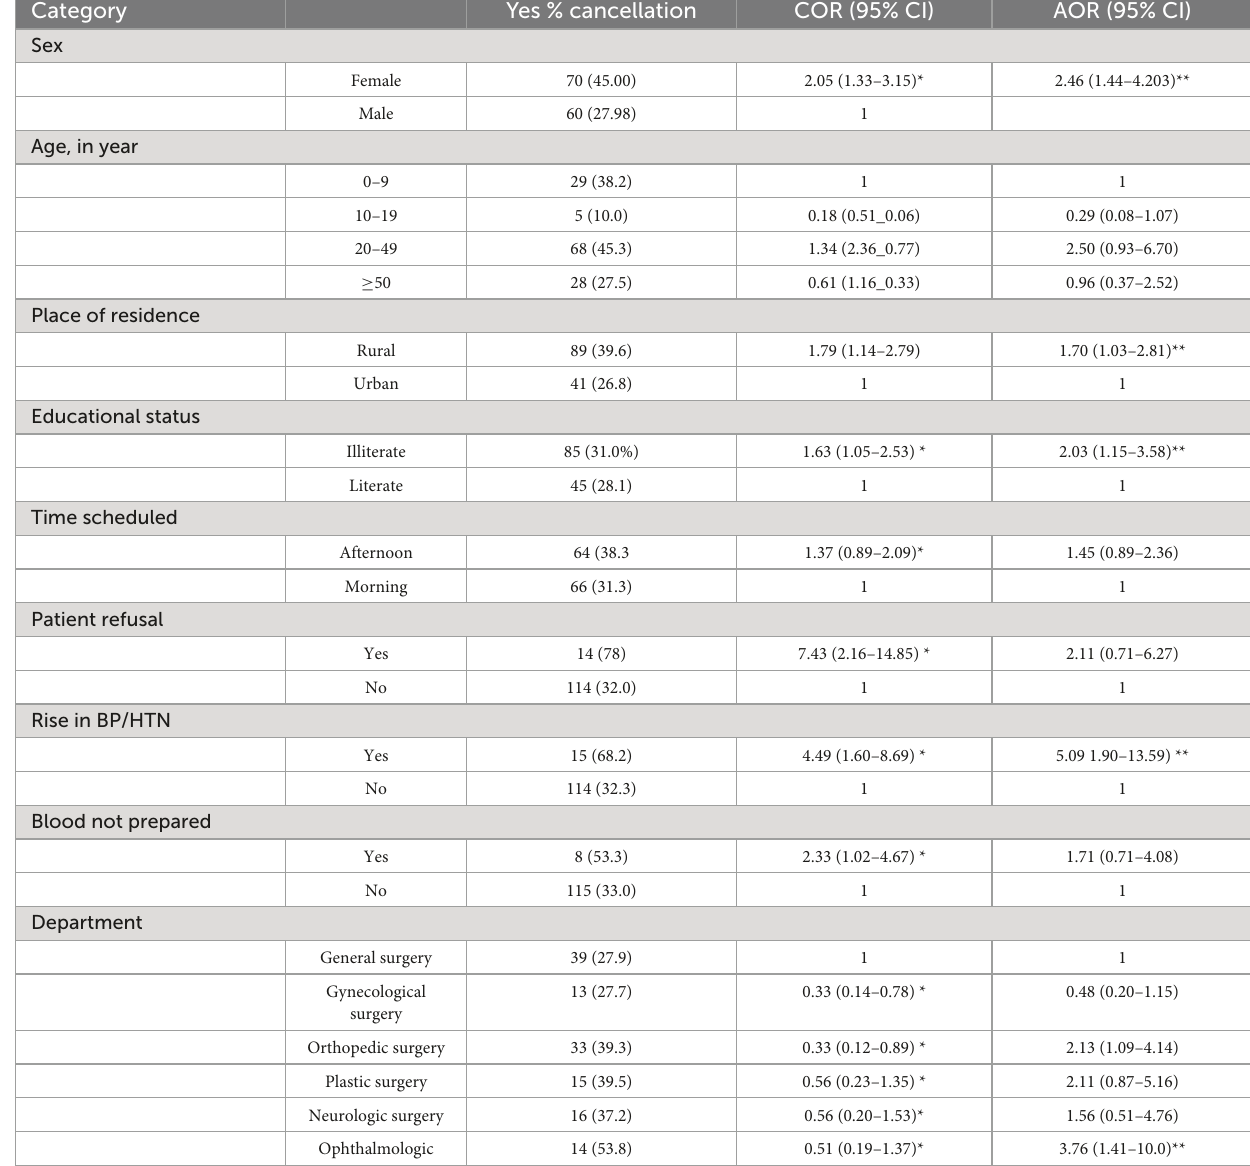
TABLE 3 Bivariate and multi-variable logistic regression analysis of factors associated with the cancellation of elective surgery in public hospitals in Harari regional state, Eastern Ethiopia ( n = 378). Category Yes % cancellation COR (95% CI) AOR (95% CI)